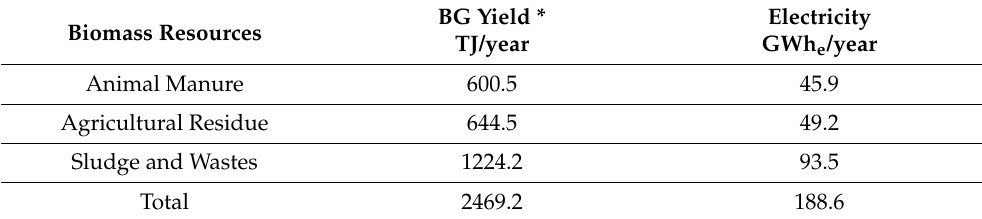
Figure 13. Scheme describing the production of biogas. Table 12. Jordan’s biogas and electricity yield potential [37].